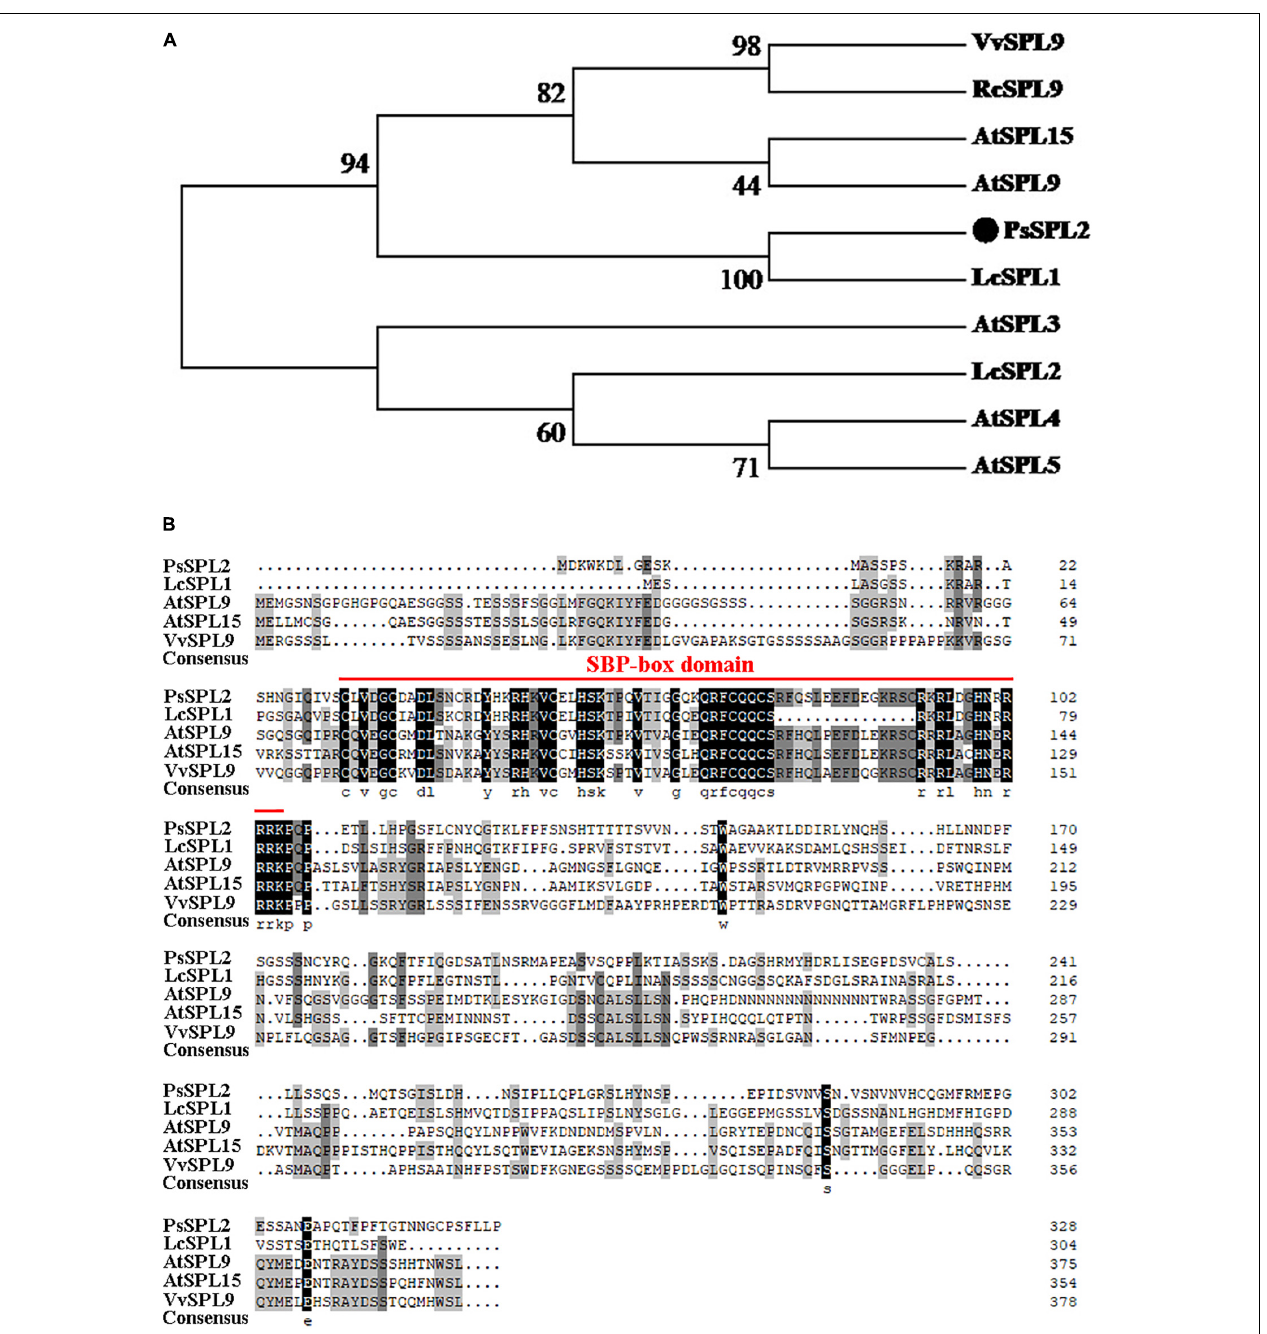
FIGURE 5 | Phylogenetic analysis of PsSPL2 and its homologous proteins. (A) Phylogenetic analysis of PsSPL2 with other species. (B) Multiple alignments of deduced amino acid sequences of PsSPL2 with other species. NCBI accessions: VvSPL9 (NP_001267898.1), RcSPL9 (XP_015582800.1), AtSPL15 (NP_191351.1), AtSPL9 (NP_181749.1), LcSPL1 (AQM55950.1), AtSPL3 (NP_565771.1), LcSPL2 (AQM55951.1), AtSPL4 (NP_175723.1), AtSPL5